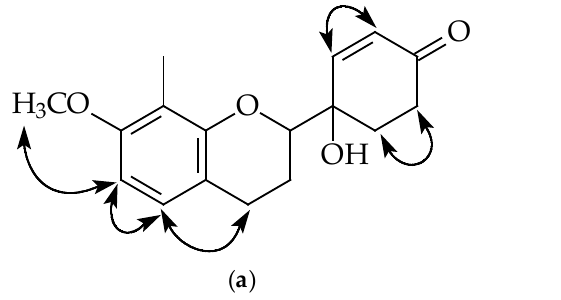
Figure 5. Key NOESY contacts ( a ) and HMBC connectivities ( b ) of compound 4 .